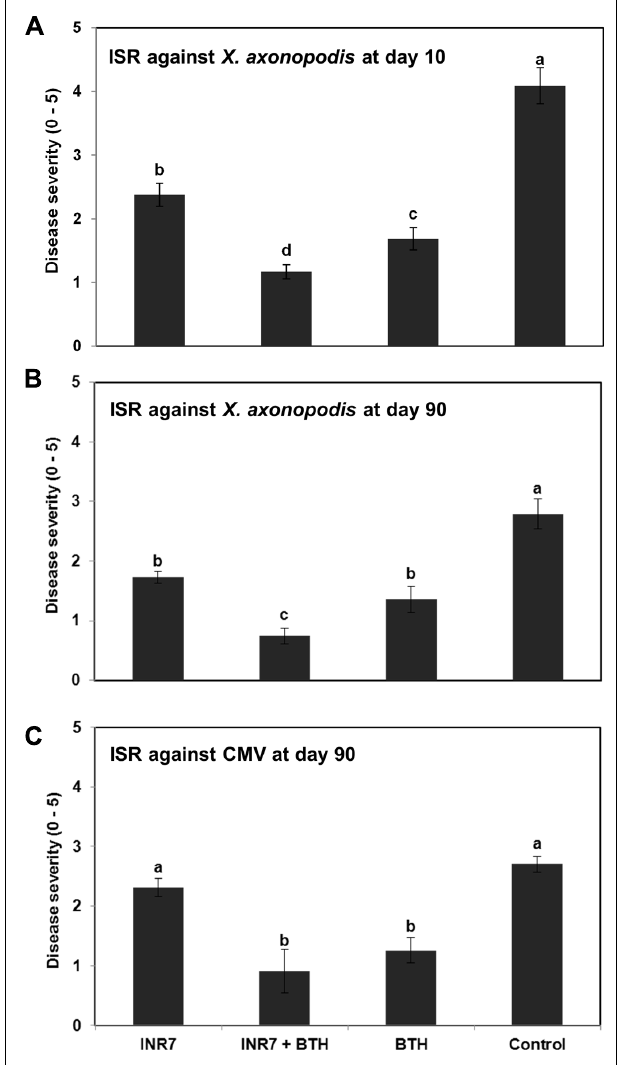
FIGURE 2 | Induction of systemic resistance by B. pumulis INR7 and benzothiadiazol in pepper under field conditions. (A,B) . Induction of plant resistance against a compatible X. axonopodis pv. vesicatoria. Disease severity was measured at 10 and 90 days after infilteration of X. axonopodis pv. vesicatoria at 10 6 cfu/ml in plants pretreated with bacterial suspension of strain INR7 (INR7), 0.5 mM BTH (BTH) and the combination (INR7 + BTH). (C) Induction of plant resistance against naturally occuring Cucumber mosaic virus . Disease severity was measured at 90 days after transplating. Bars represent the mean ± SE (sample size, N = 40 replications per treatment). Different letters indicate significant differences between treatments ( P = 0.05 according to least significant